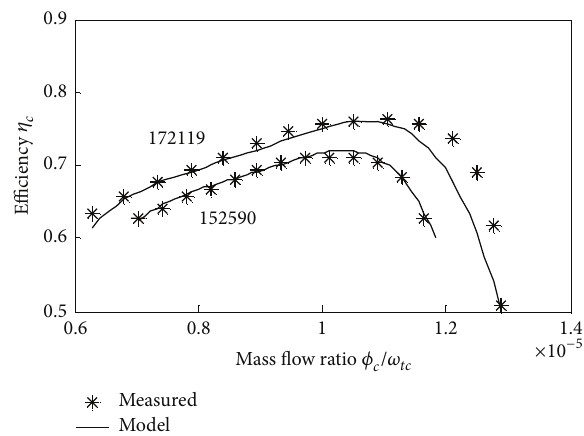
Figure 9: Efficiency model in polynomial form at stationary engine conditions (turbo speeds: 172119 rpm and 152590 rpm).